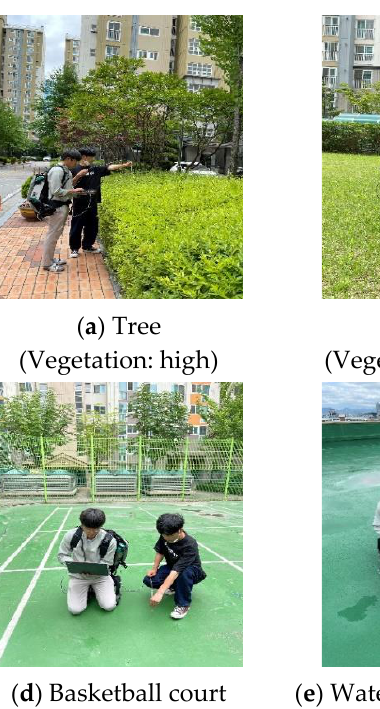
Figure 8. Calibration of ASD FieldSpec4 spectrometer. Figure 9 is a field photograph measuring reflectance by wavelength using an ASD FieldSpec4 spectrometer for tree, grass, basketball court, waterproof coating roof, and road.